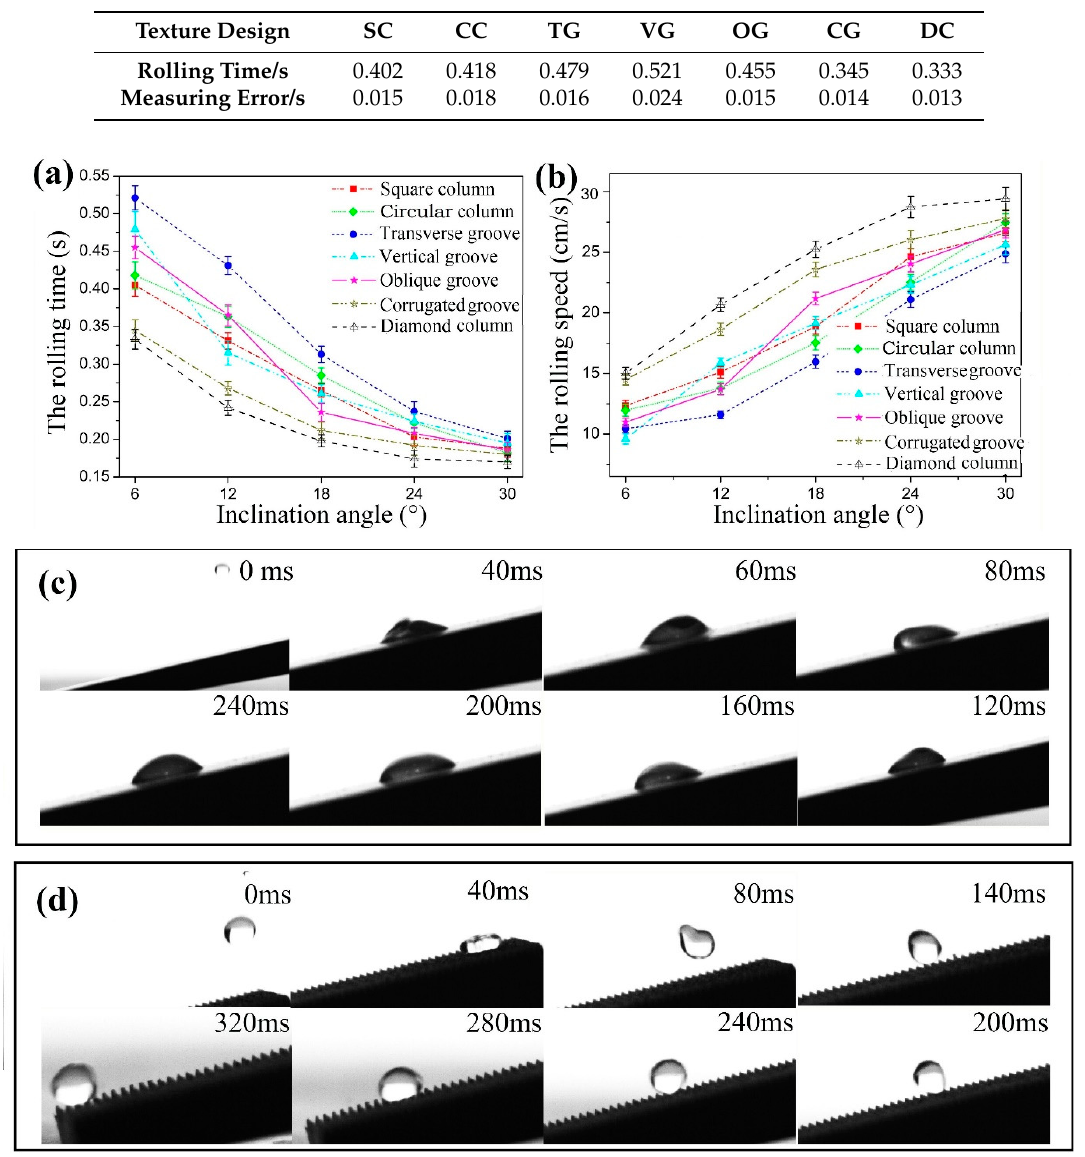
Table 2. The rolling time of the droplets on different textured surfaces.